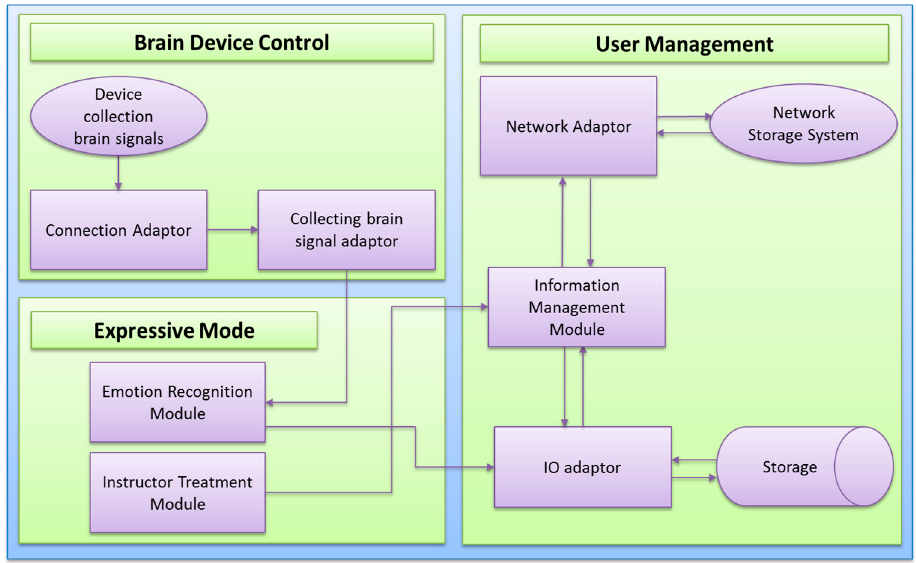
Figure 2. System level component diagram (main system components).